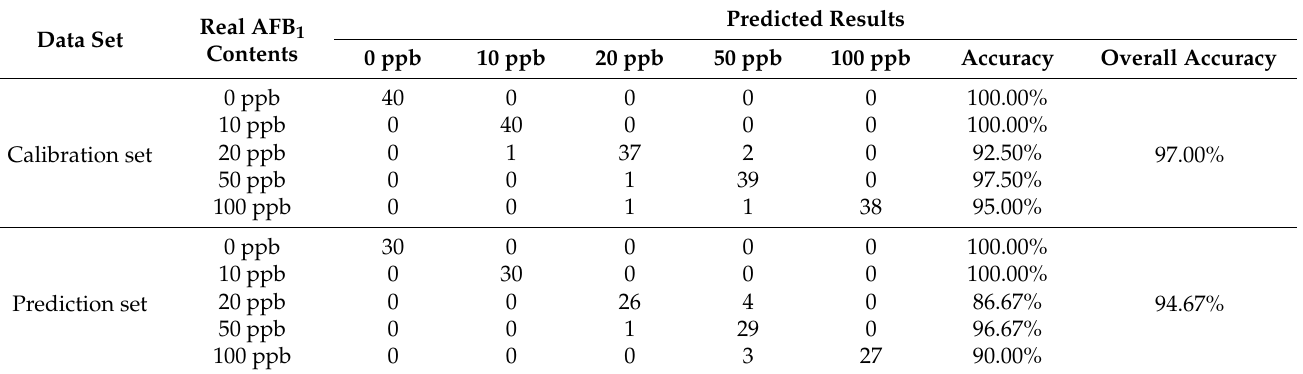
Table 1. The confusion matrix of predicted results of AFB 1